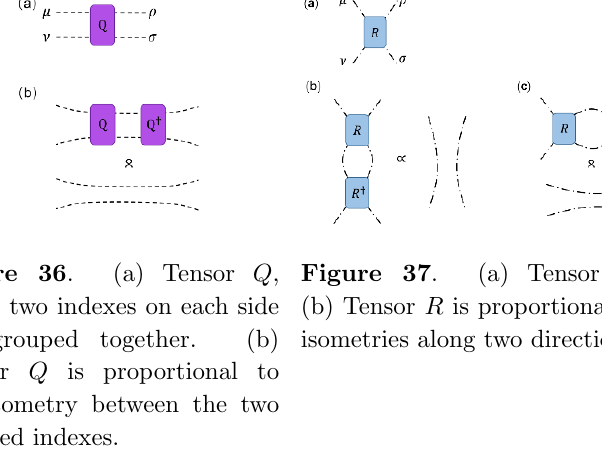
Figure 35 . (a) Tensor U . (b) Tensor U is proportional to an isometry.